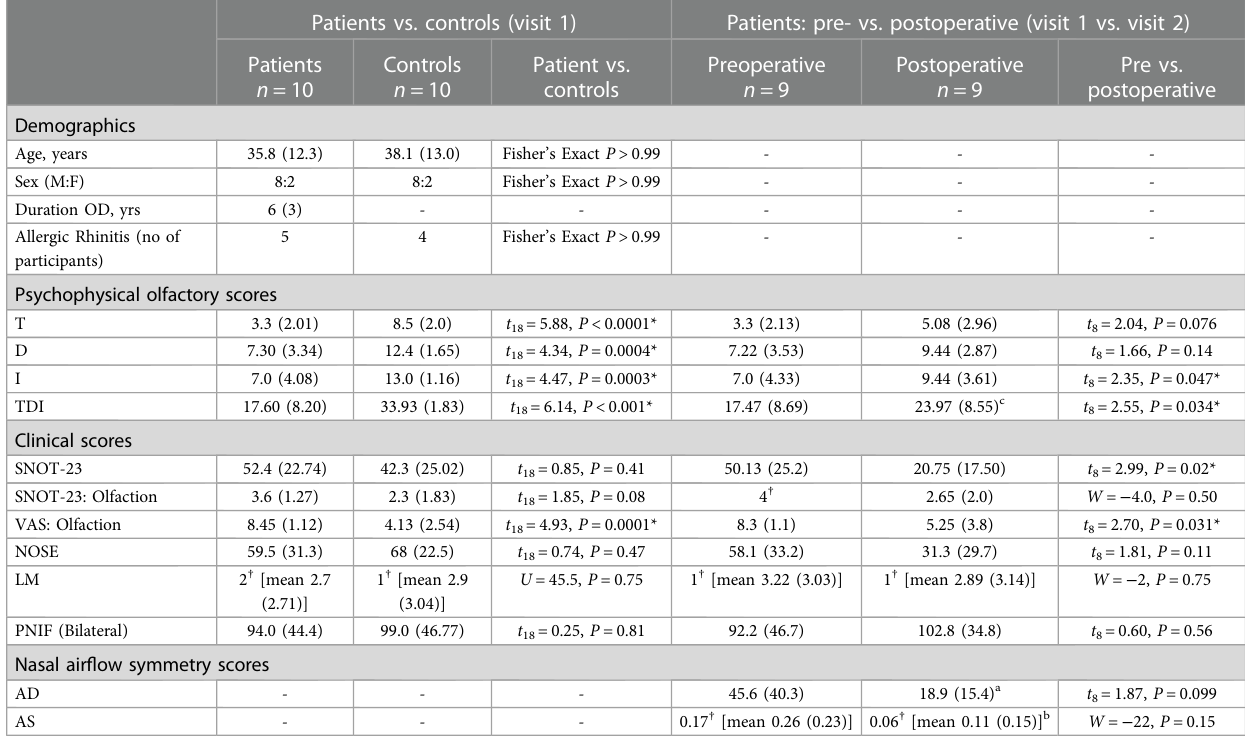
TABLE 2 Group average demographic, nasal air fl ow symmetry, psychophysical and clinical scores in patients and controls, shown as mean (SD) or median.